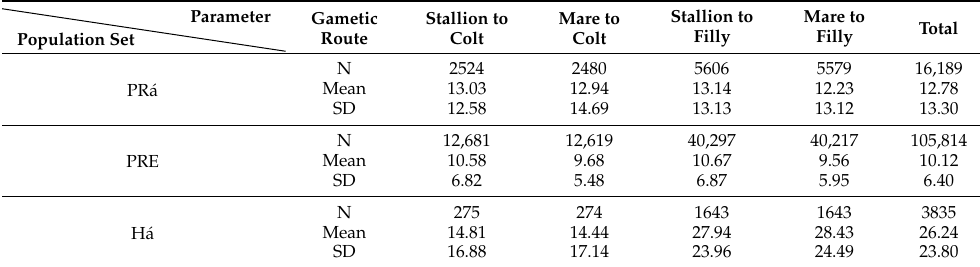
Table 3. Generation intervals (years) for the four gametic routes in the Spanish Purebred (PRE), Arabian Purebred (PR á ) and Hispano-Arabian (H á ) breeds. Population